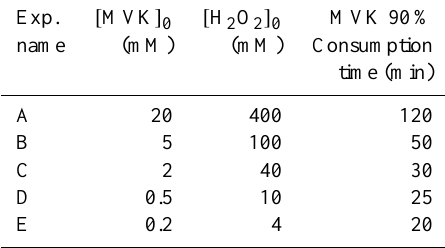
Table 1. Experimental conditions of • OH oxidation of MVK in the aqueous phase. All experiments are performed at 25 ◦ C. Time 0 cor- responds to MVK injection in the photoreactor (samples taken at 0, 5, 10, 15, 30, 50, 75, 105, 150min). Aqueous-phase character- ization was performed using UPLC-ESI-MS and UHPLC-UV for all experiments, and IC-ESI-MS analyses were made only during experiments A and B. Aerosol characterization after nebulization using SMPS and AMS was performed for all experiments.